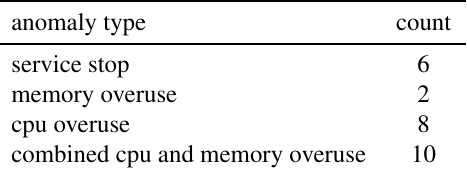
Table 1: Final anomaly count per